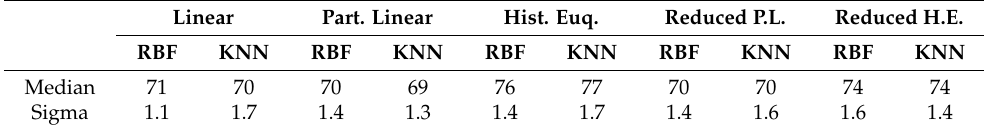
Table 7. F1 score results of the test series with log contour moments. Linear Part. Linear Hist. Euq. Reduced P.L. Reduced H.E. RBF